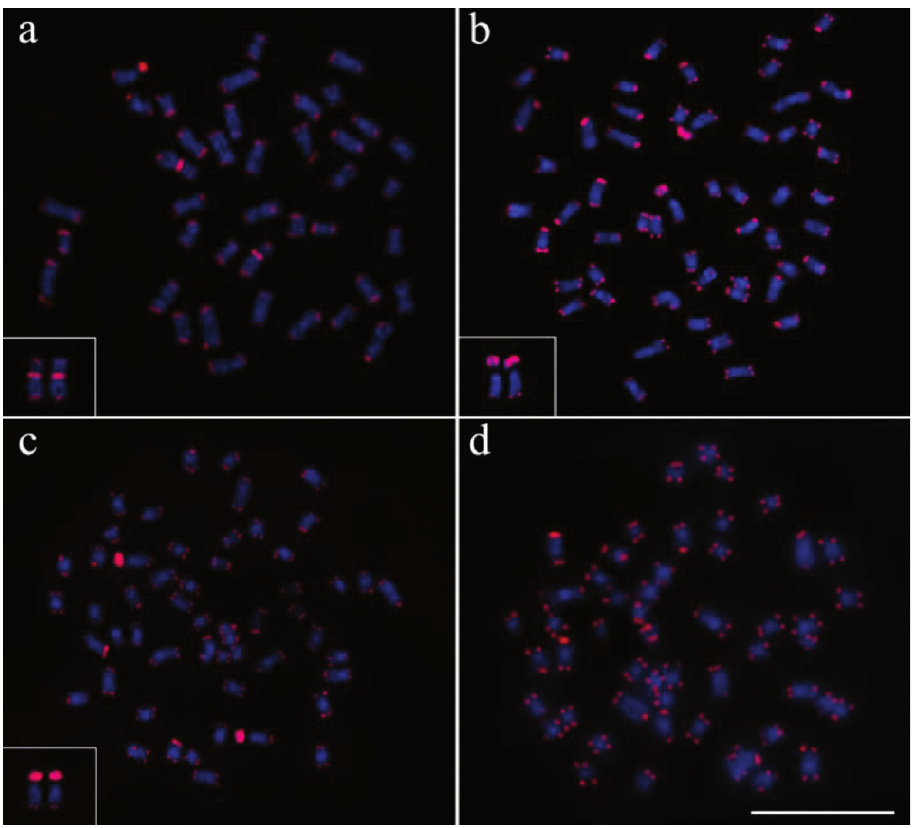
Figure 6a–d. Distribution pattern of telomeric sites in metaphases of the representatives of the four spe- cies of Gymnotus analyzed. ( a ) G . sylvius (featured interstitial telomeric sites – ITS), ( b ) G . inaequilabiatus , ( c ) G . cf. carapo and ( d ) G . pantherinus . Bar =